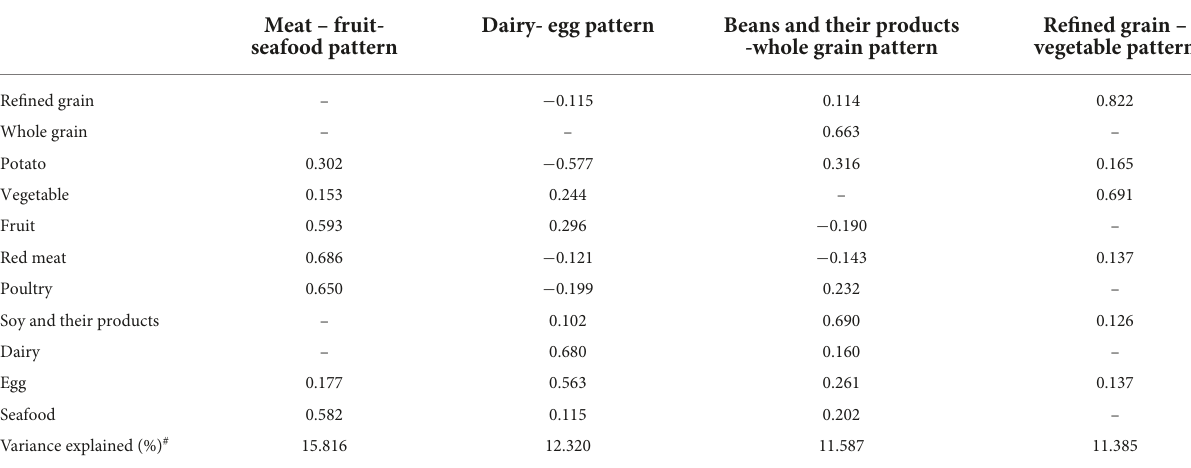
TABLE 1 Factor loadings for the four dietary patterns identified by PCA analysis in 1,639 patients with